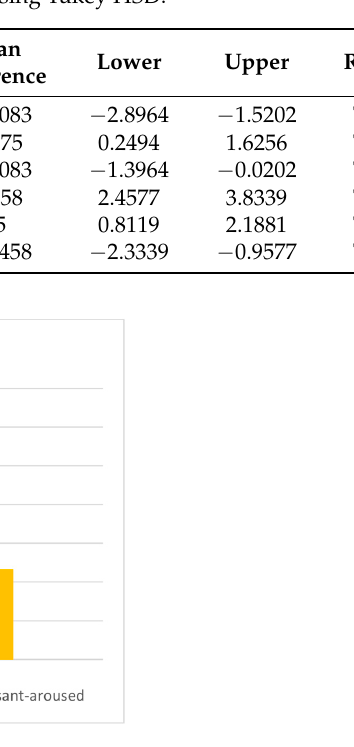
Figure 6. Analysis of the valence values between the four emotion-eliciting conditions. Table 3. Multiple comparisons of mean valence scores using Tukey HSD.